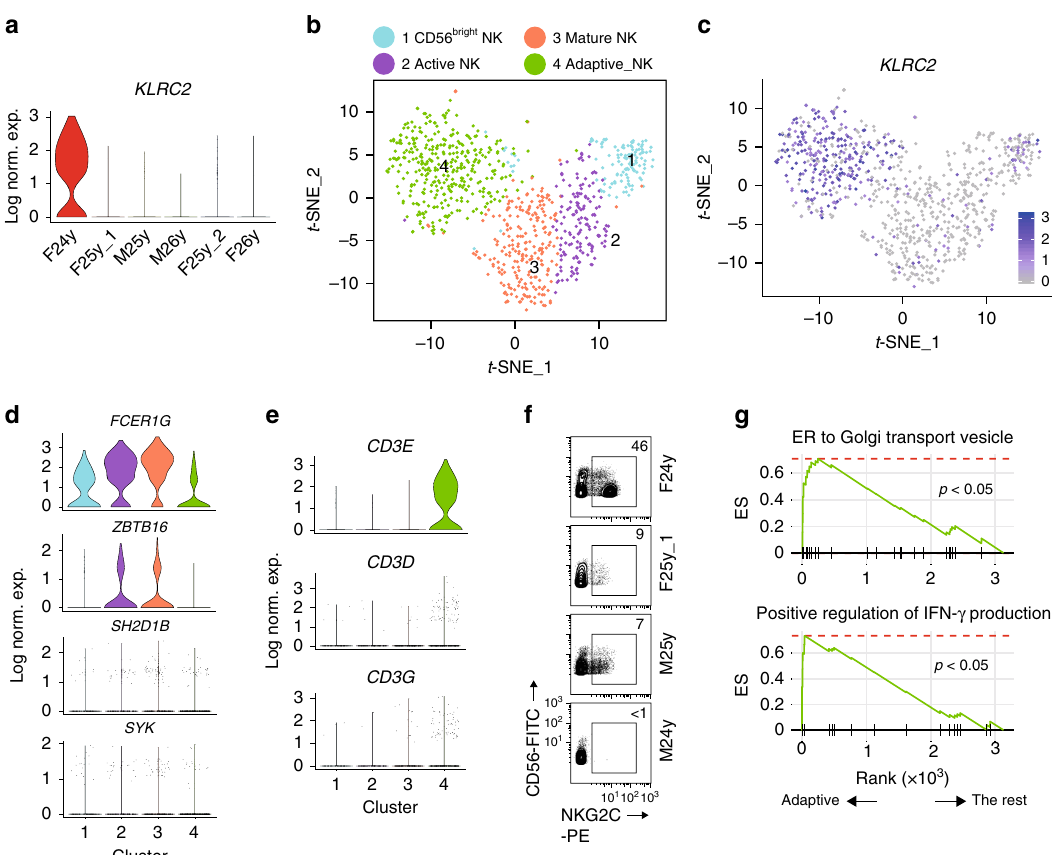
Fig. 5 Identi fi cation of adaptive NK cells from a 24-year-old female donor. a The expression of KLRC2 in each donor cells within the “ Adaptive NK ” cluster were shown in violin plots. The y -axis represents log-normalized expression value. b The t -SNE plot demonstrates four distinct NK clusters from BM of the 24-year-old female donor. c The expression of KLRC2 of the 24-year-old female sample was overlaid on the t -SNE plot. d Violin plots demonstrate the expression of FCER1G , ZBTB16 , SH2D1B , and SYK in four clusters from the 24-year-old female donor sample. The y -axis represents log-normalized expression value. e Violin plots demonstrate the expression of CD3E , CD3D , and CD3G in four clusters from the 24-year-old female donor sample. The y - axis represents log-normalized expression value. f Expression of NKG2C on NK cells (gated on PI − Lin − TCR α / β − TCR γ / δ − CD56 + cells) was assessed by fl ow cytometry using cryopreserved samples from four donors. g Selected gene sets enriched in the “ Adaptive NK ” cluster compared to the rest of the cells were plotted. See also Supplementary Fig. F-actin) peaked in the “ Mature NK ” cluster (Fig. 6a) 46 – 48 . We also